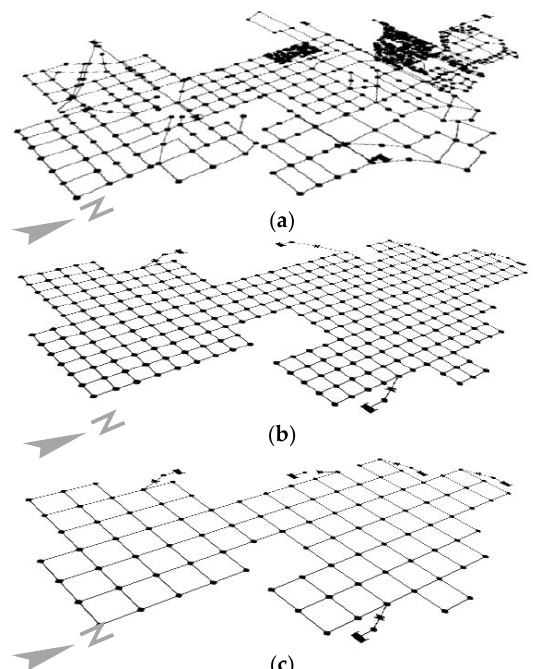
Figure 3. Water distribution models ( a ) CCGA model with different levels of detail due to planning stages; ( b ) semi-virtual model created with the Modular Design System (MDS) for the CCGA zone with a fine grid (MDS1); ( c ) semi virtual model for the CCGA zone with a coarse grid (MDS2).